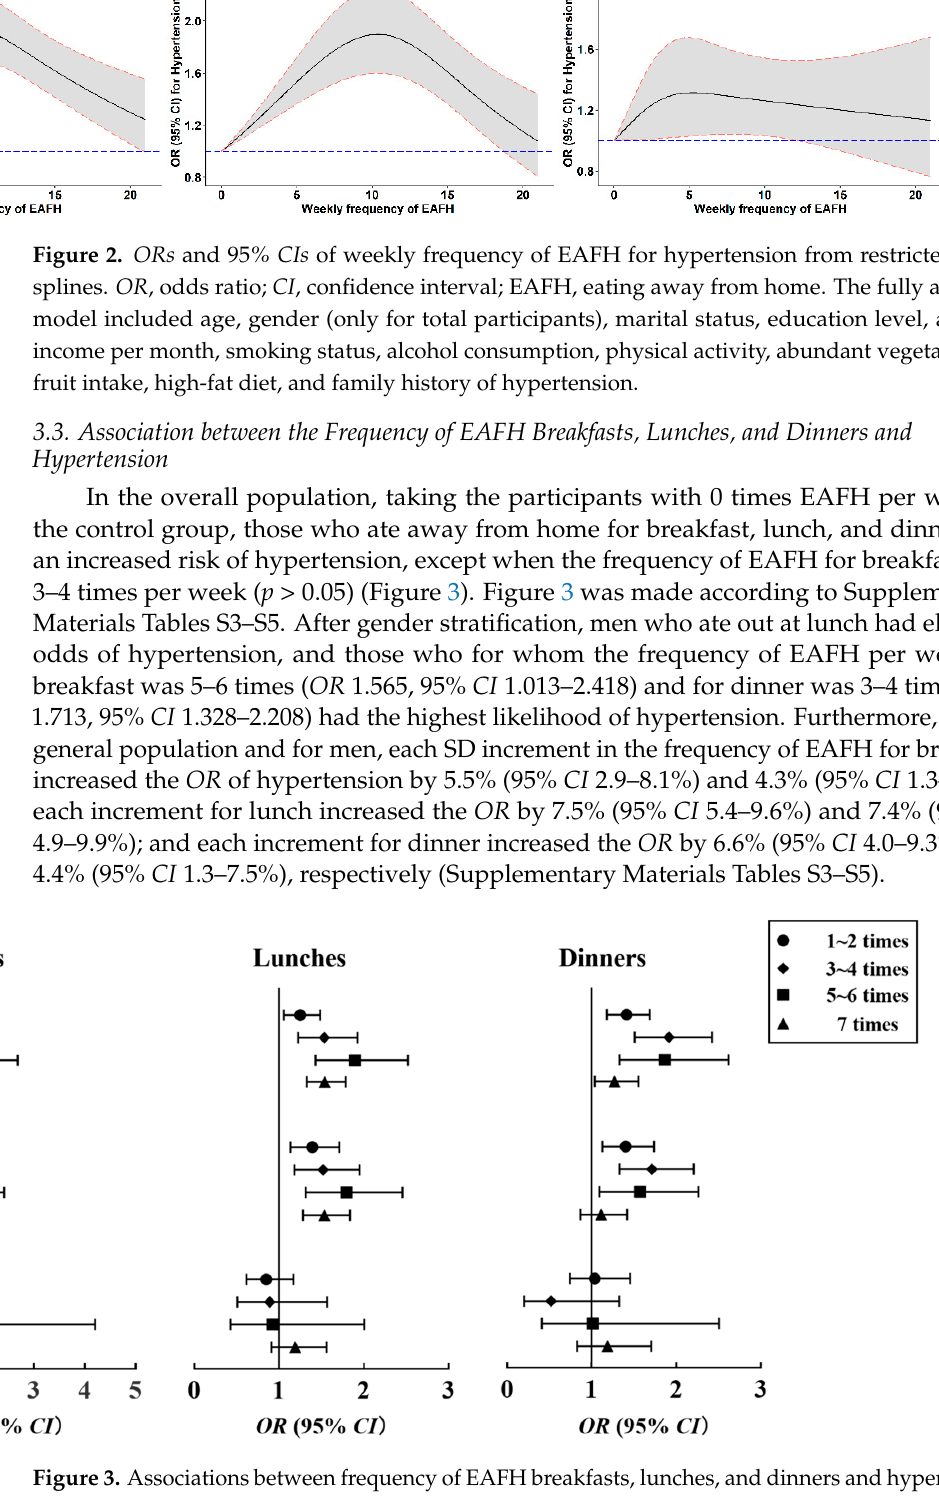
Figure 1. Association between frequency of EAFH and blood pressure. CI , confidence interval; SBP, systemic blood pressure; DBP, diastolic blood pressure; EAFH, eating away from home. Adjusted for age, gender (only for total participants), marital status, education level, average income per month, smoking status, alcohol consumption, physical activity, abundant vegetable and fruit intake, high-fat diet, and family history of hypertension.